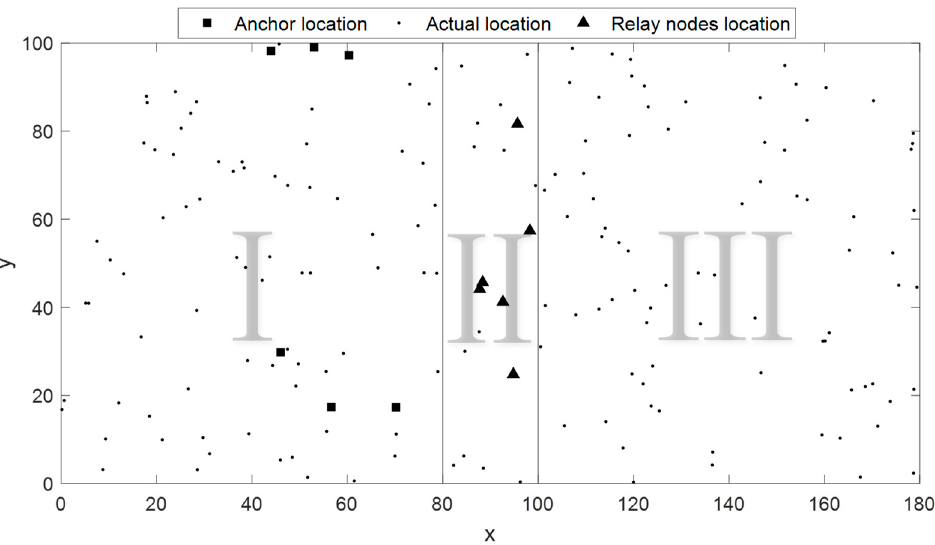
Figure 9. Illustration of large-scale scenario used in this study.